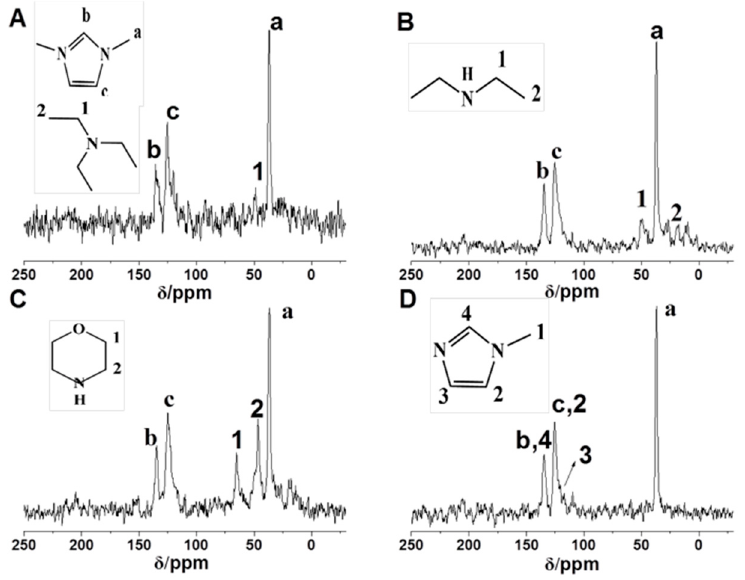
Figure 9. 13 C NMR spectra of samples under different types of templates (( A ): S2-TEA, ( B ): S2-DEA, ( C ): S2-MOR, and ( D ): S2-N-MIM).